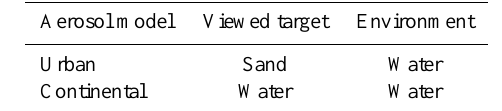
Aerosol model Viewed target Environment Urban Sand Water Continental Water Water